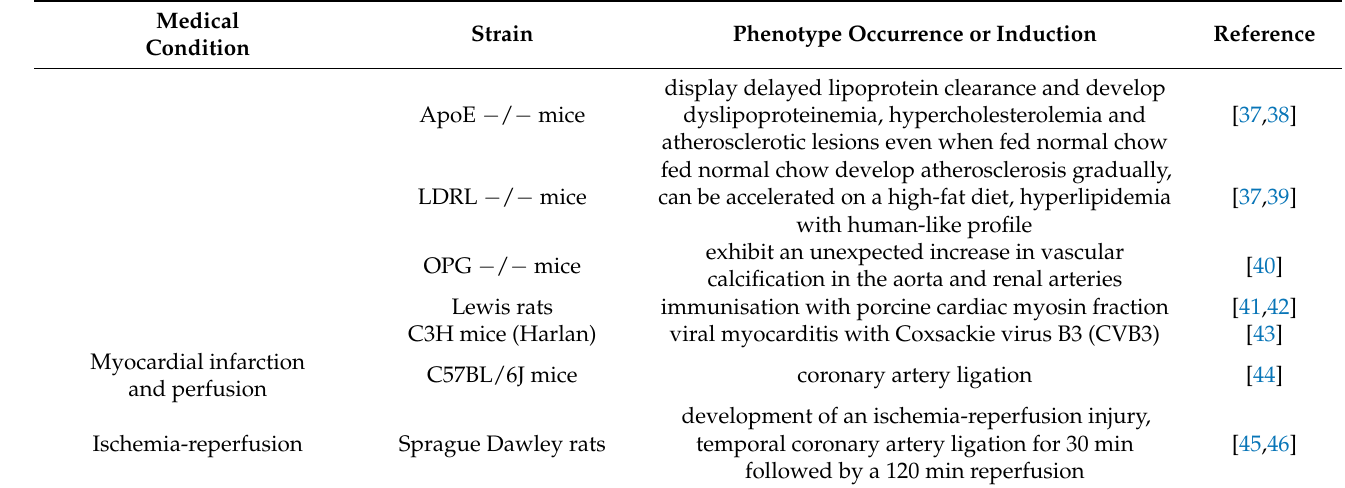
Table 2. The examples of cardiovascular diseases animal